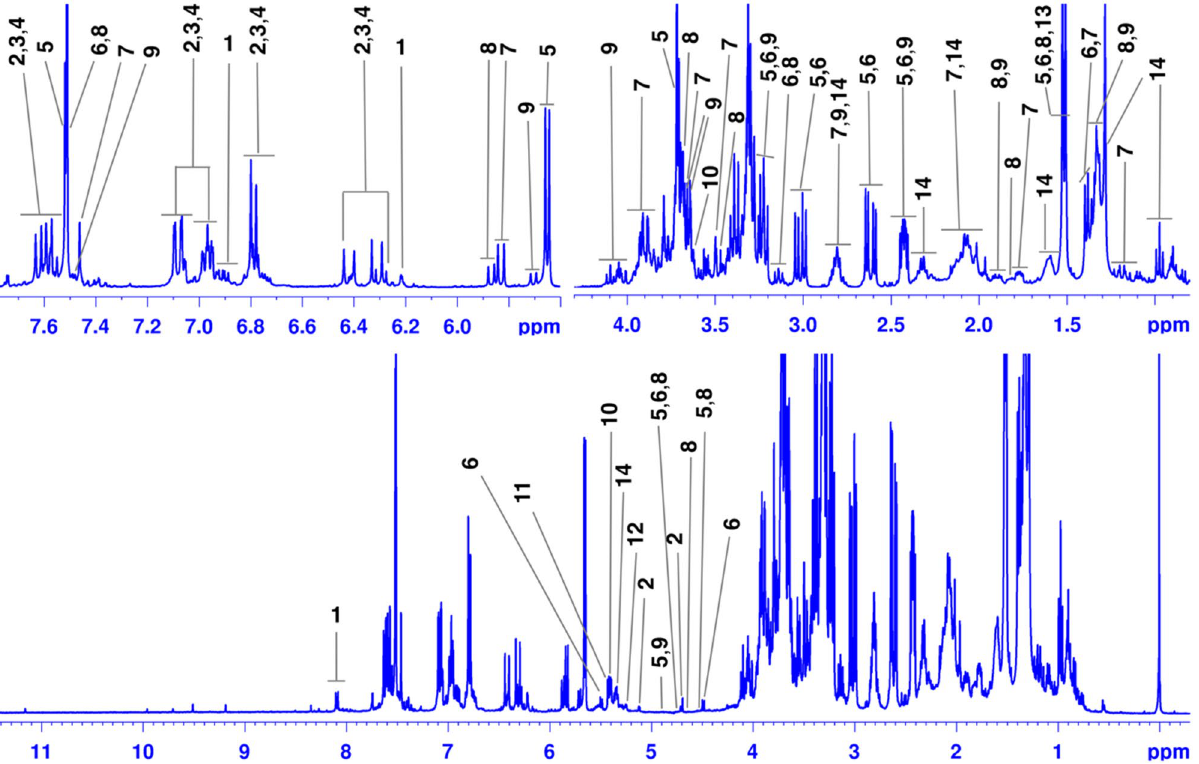
Figure 1. 1 H HR-MAS NMR (400.13 MHz) spectrum showing signal assignments for the metabolites detected in leaf tissue (10 ± 0.05 mg swollen in 40 µL CD 3 OD) from Citronella gonogonha . Metabolites: 1 , kaempferol- 3- O -dihexoside; 2 , caffeoyl glucoside; 3 , 3- O -caffeoylquinic acid; 4 , 5- O -caffeoylquinic acid; 5 , kingiside; 6 , 8-epi-kingisidic acid; 7 , (7 α )-7- O -methylmorroniside; 8 , (7 β )-7- O -methylmorroniside; 9 , alpigenoside; 10 , sucrose; 11 – 12, α -glucoses; 13 , alanine; 14 , fatty (linolenic) acid. NMR spectrum was produced in TopSpin v3.6.3 software package (Bruker BioSpin: https:// www. bruker. com), signal annotations were manually generated in Microsoft PowerPoint v16.56 (https:// offic ecdnm ac. micro soft. com) and final figure was generated in GIMP v2.10.24 software package (https:// www. gimp.